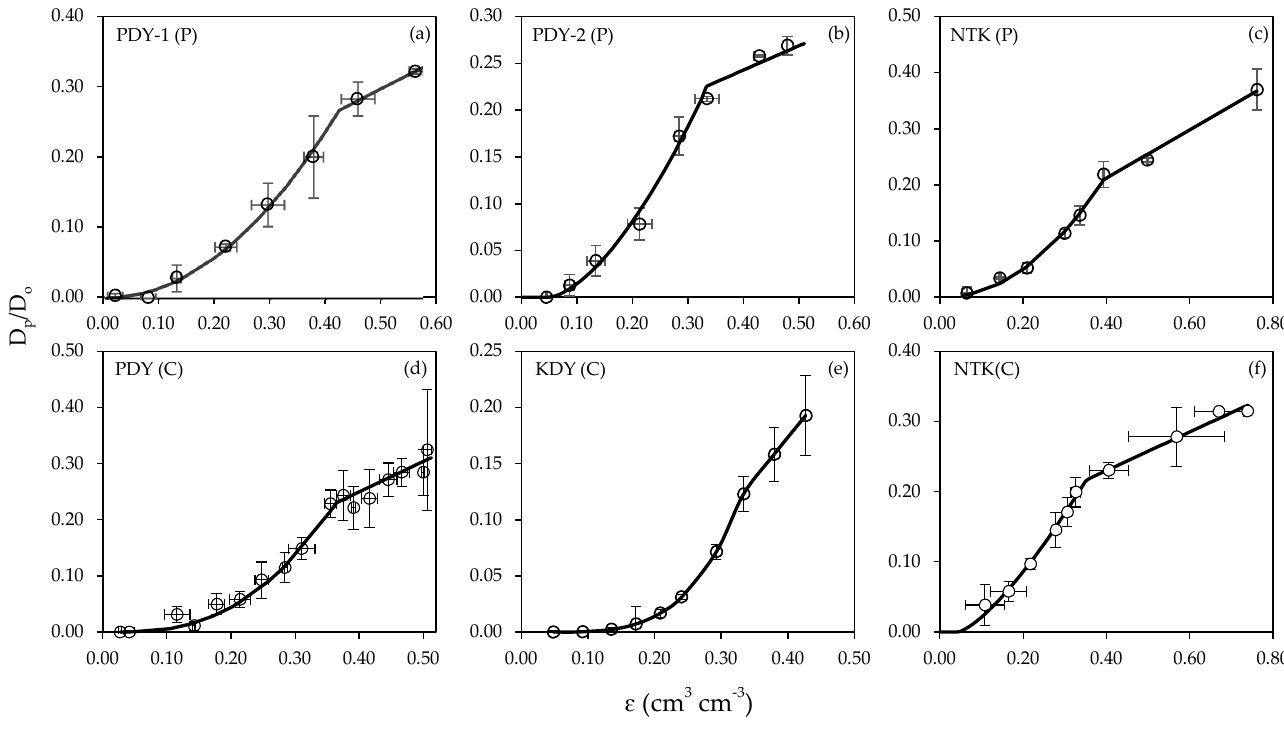
Figure 02 Figure 2. Measured soil-gas diffusivity against air-filled porosity for six repacked soils (( a – f ), together with proposed descriptive two-region model (Equations (6) and (7)). PDY; Peradeniya (Sri Lanka), NTK; Nishi-Tokyo (Japan), KDY; Kandy (Sri Lanka). P and C in parentheses denote Pasture and Cultivated,